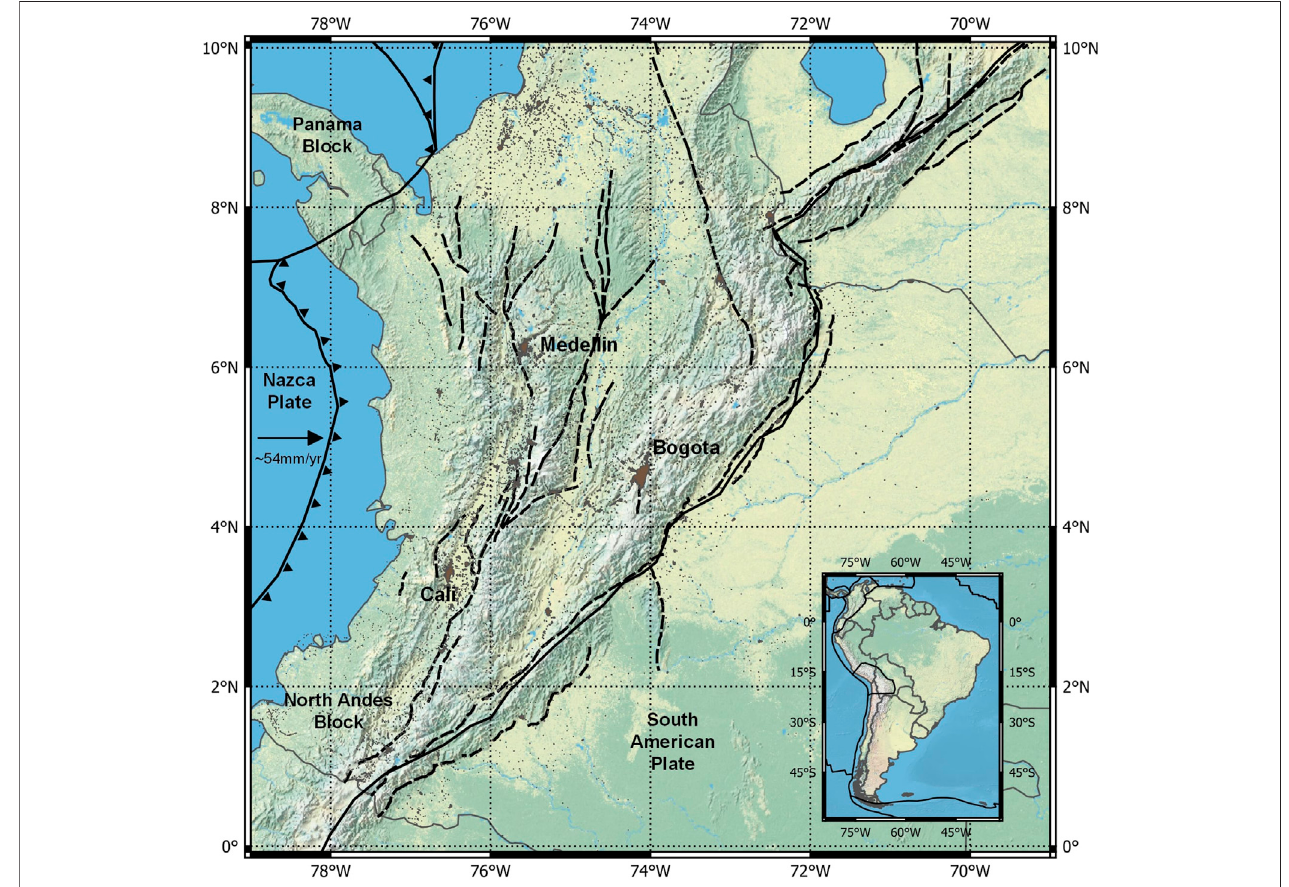
FIGURE 1 | Location of Bogota, Medellin, and Cali as well as some characteristics of the seismicity in the country. Dash-dotted lines: active faults traces. Continuous lines: boundary tectonic plates.